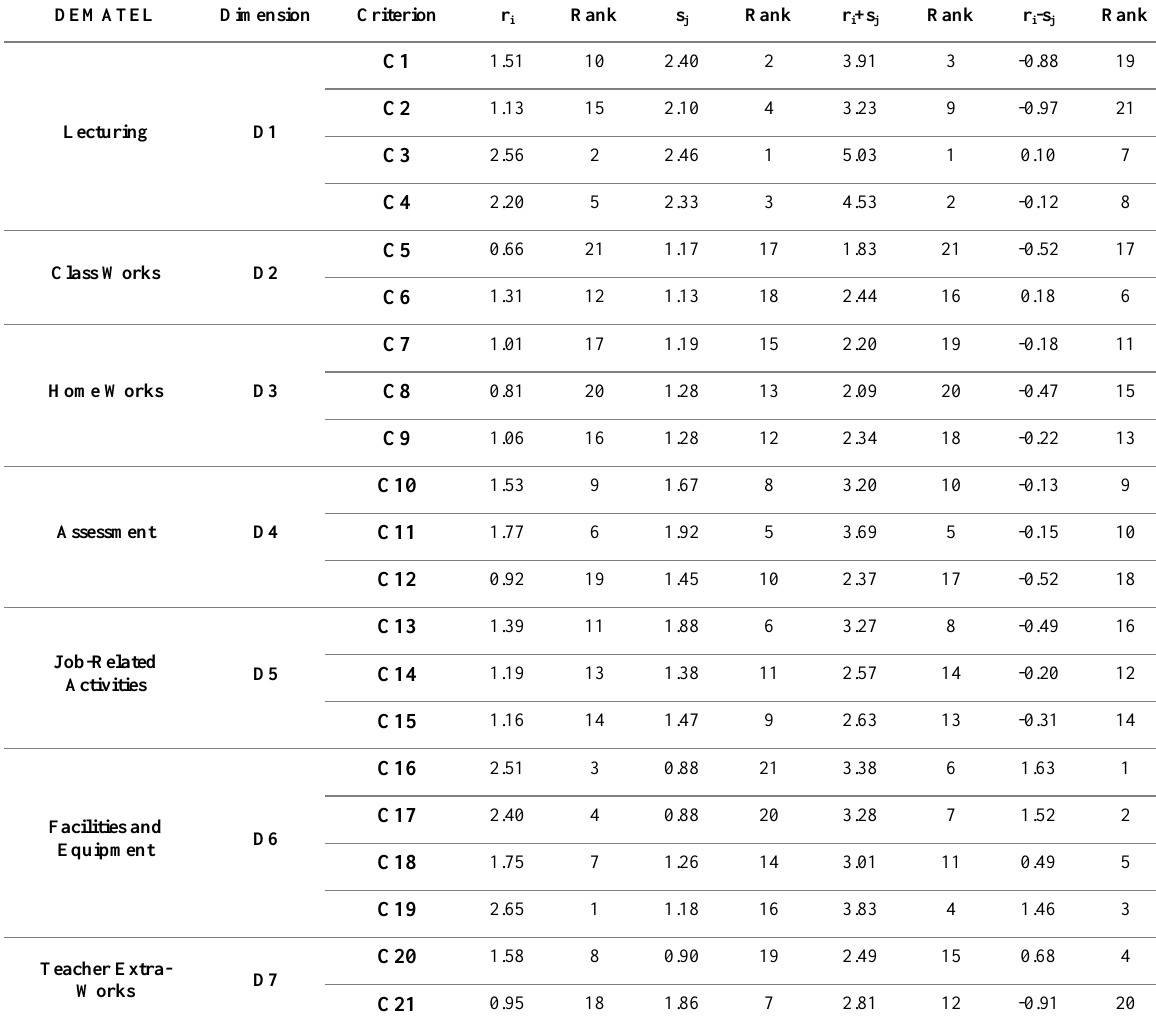
Table 10. Values for influence, and objectivity, sum of influence and objectivity, and net influence for each criterion and its relevant rank.